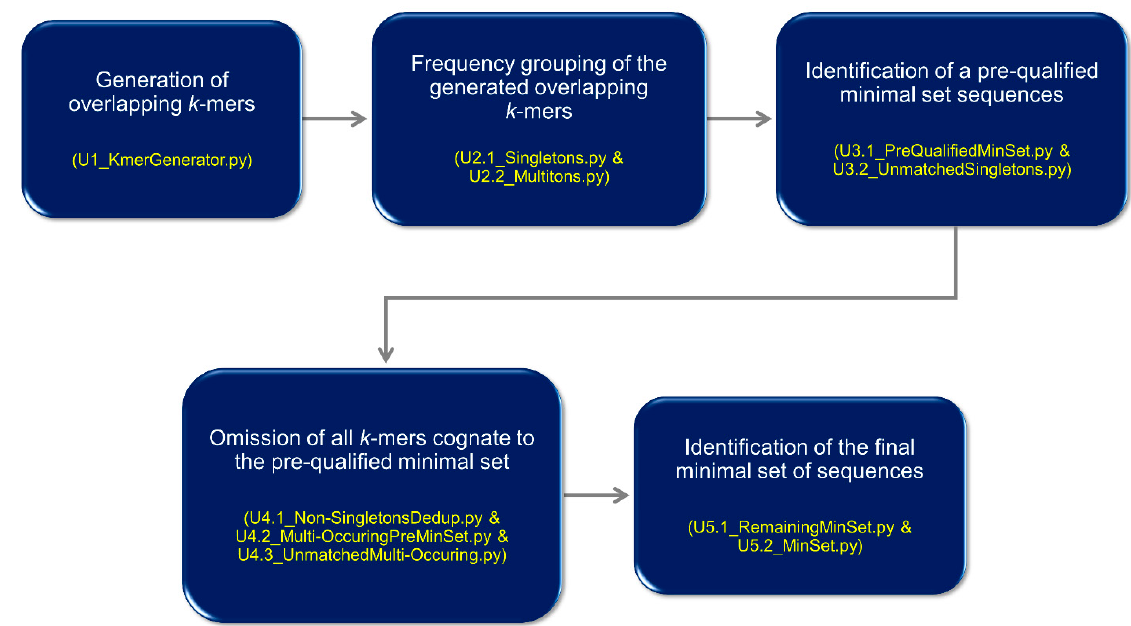
Scheme 1. Overview of the UNIQmin tool with the respective Python script(s) employed for the relevant steps of the algorithm algorithm indicated.